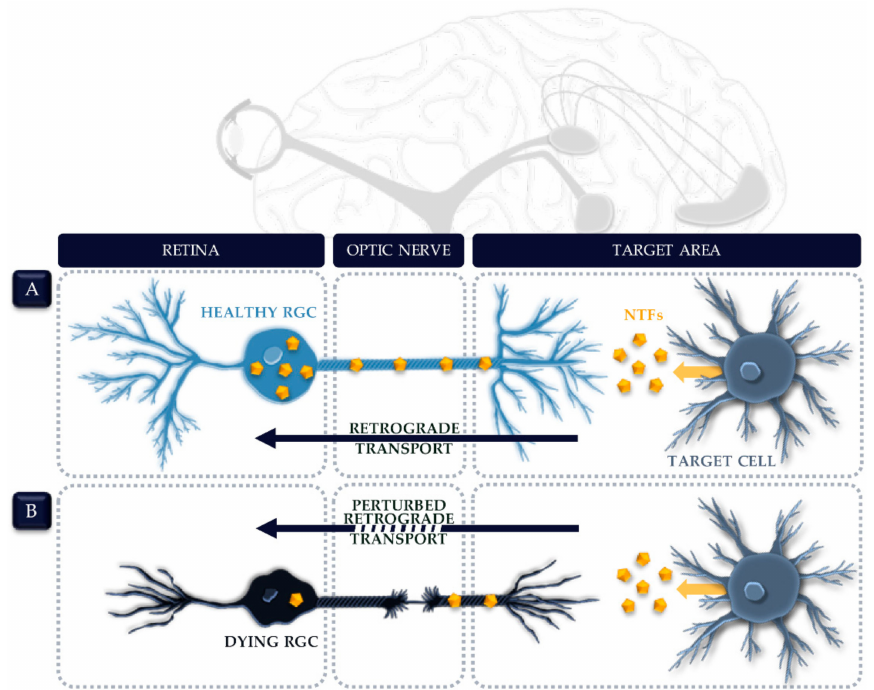
Figure 1. The neurotrophic factor (NTF) deprivation theory in the adult visual system. ( A ) Under physiological conditions, NTFs are secreted by cells in target brain centers and retrogradely transported alongside the optic nerve towards the retinal ganglion cells (RGCs). ( B ) In situations where axonal transport is perturbed—as witnessed in glaucoma and other optic neuropathies—RGCs are deprived from target-derived NTFs. According to the NTF deprivation theory, this scarcity is the final push that forces the struggling RGCs to surrender to the injury stressors and undergo